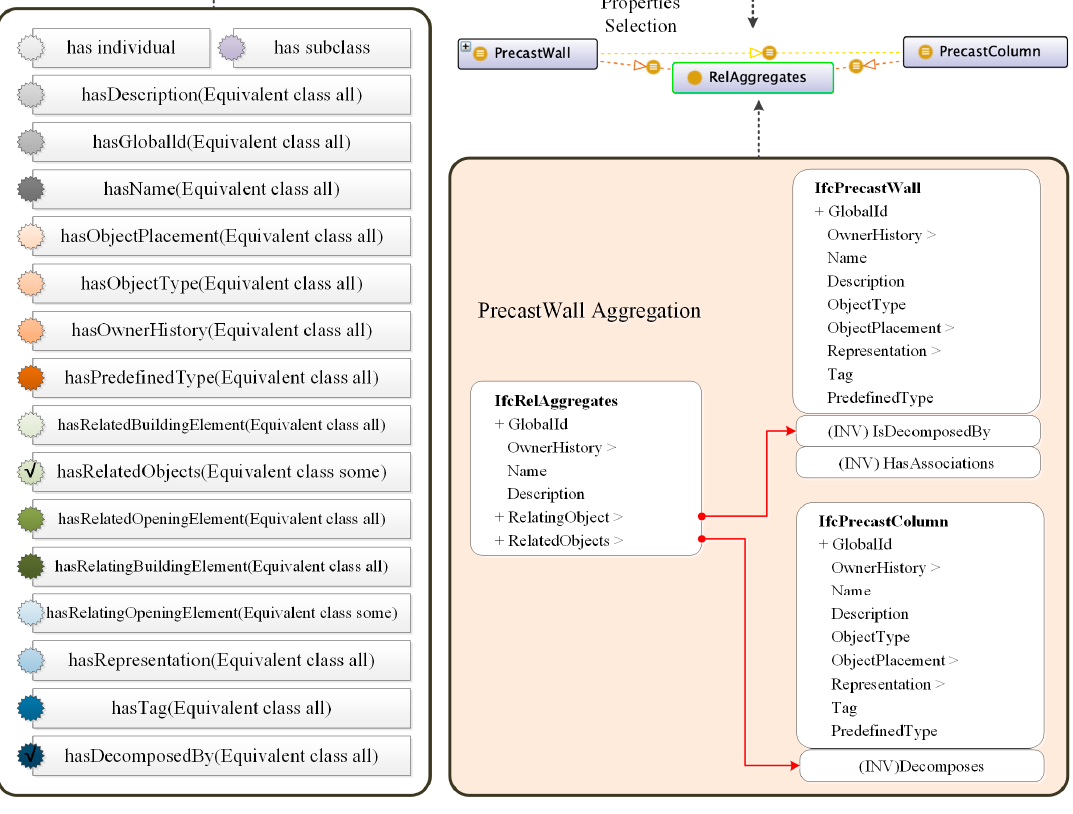
Figure 14. Conceptual diagram of prefabricated walls and columns aggregated by RelAggregates.